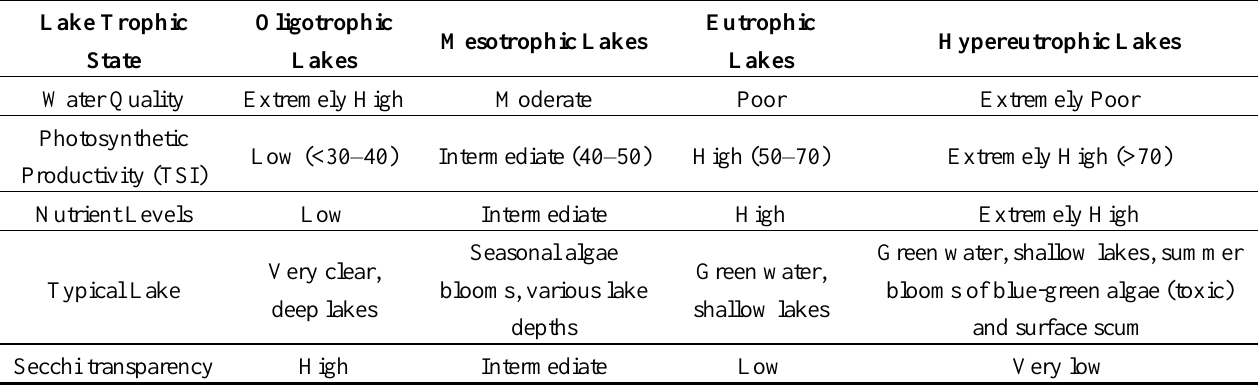
Table 3. Relationships between Carlson’s Trophic State Index (TSI) (productivity) and Secchi disk transparency, derived from [47 –